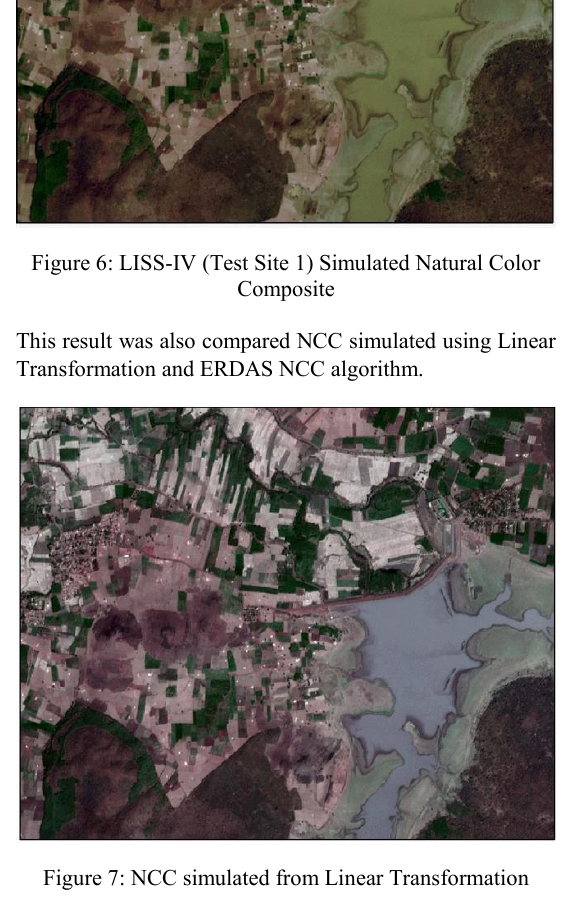
Figure 7: NCC simulated from Linear Transformation a. Linear Transformation is able to achieve true color for Figure 5: a. Spectral profile (b) Spatial Profile across part vegetation and other land cover except water body of Test Site 1